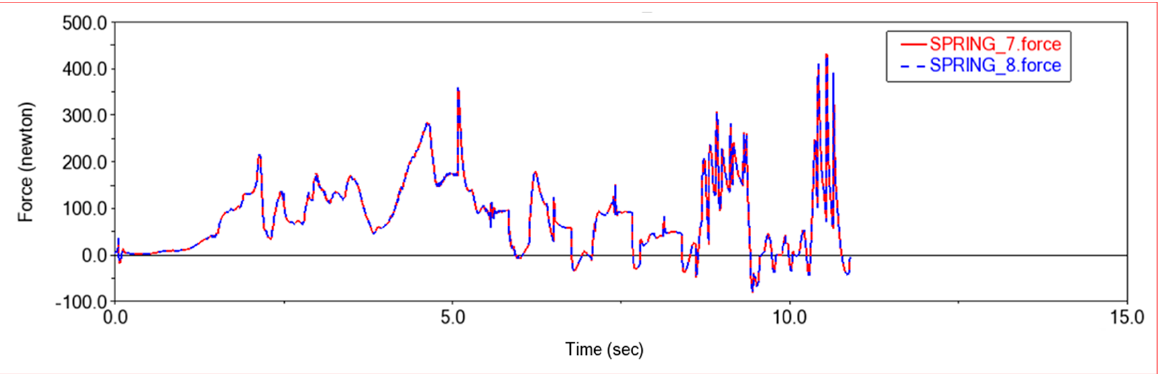
Figure 12. Force diagram of rear frame shock absorber in Experiment 1. SPRING-7-Rear frame left shock absorber; SPRING-8-Rear frame right shock absorber.